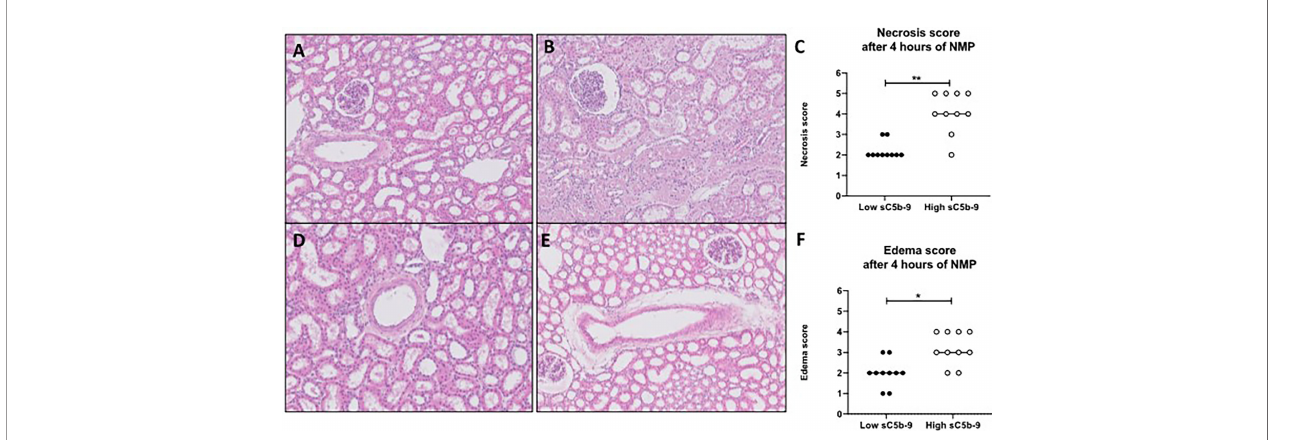
FIGURE 6 | H&E-stained biopsies of porcine kidneys after 4 h of normothermic machine perfusion. (A – C) Proximal tubular necrosis score (scored from 1 to 5) was assessed histologically after 4 h of normothermic machine perfusion (NMP). (A) Representative picture of a low necrosis score (score 2) after 4 h of NMP. (B) Representative picture of a high necrosis score (score 5) after 4 h of NMP. (C) Graph of the overall necrosis score after 4 h of normothermic machine perfusion. Kidneys with low sC5b-9 perfusate levels ( n = 10) had signi fi cantly lower necrosis scores than kidneys with high sC5b-9 perfusate levels ( n = 10). (D, E) Edema score (score from 1 to 5) was assessed histologically after 4 h of NMP. (D) Representative picture of a low edema score (score 1). (E) Representative picture of a high edema score (score 4). (F) Graph of the overall edema score after 4 h of normothermic machine perfusion. Kidneys with low sC5b-9 perfusate levels ( n = 10) had signi fi cantly lower edema scores than kidneys with high sC5b-9 perfusate levels ( n = 10). Subgroups were based on the median sC5b-9 perfusate levels after 4 h of normothermic machine perfusion. * p < 0.05, ** p < 0.01. Images were obtained by using Leica Confocal Software. All magni fi cations ×100. sC5b-9, soluble C5b- 9; NMP, normothermic machine perfusion.